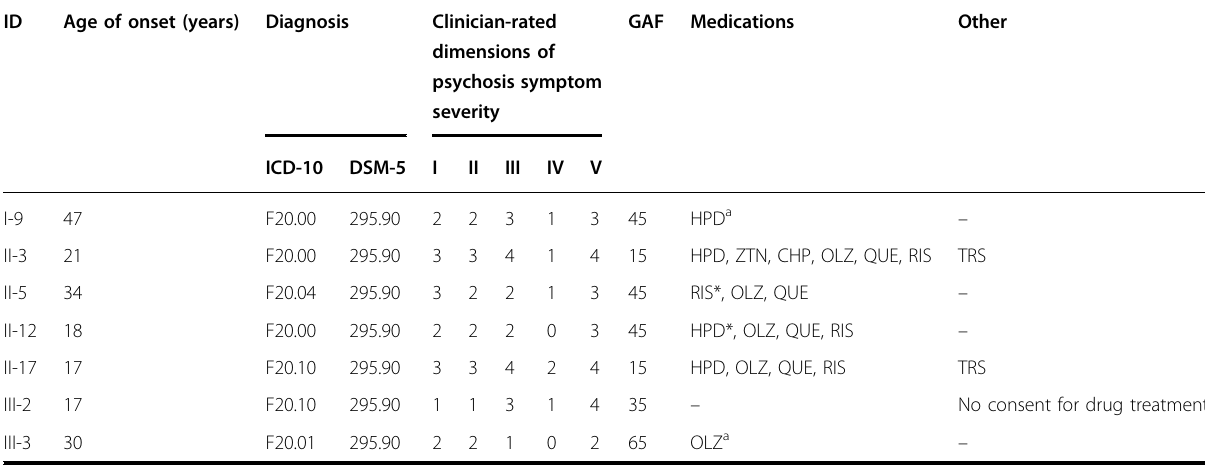
Table 1 Clinical presentation of the Japanese family including multiple